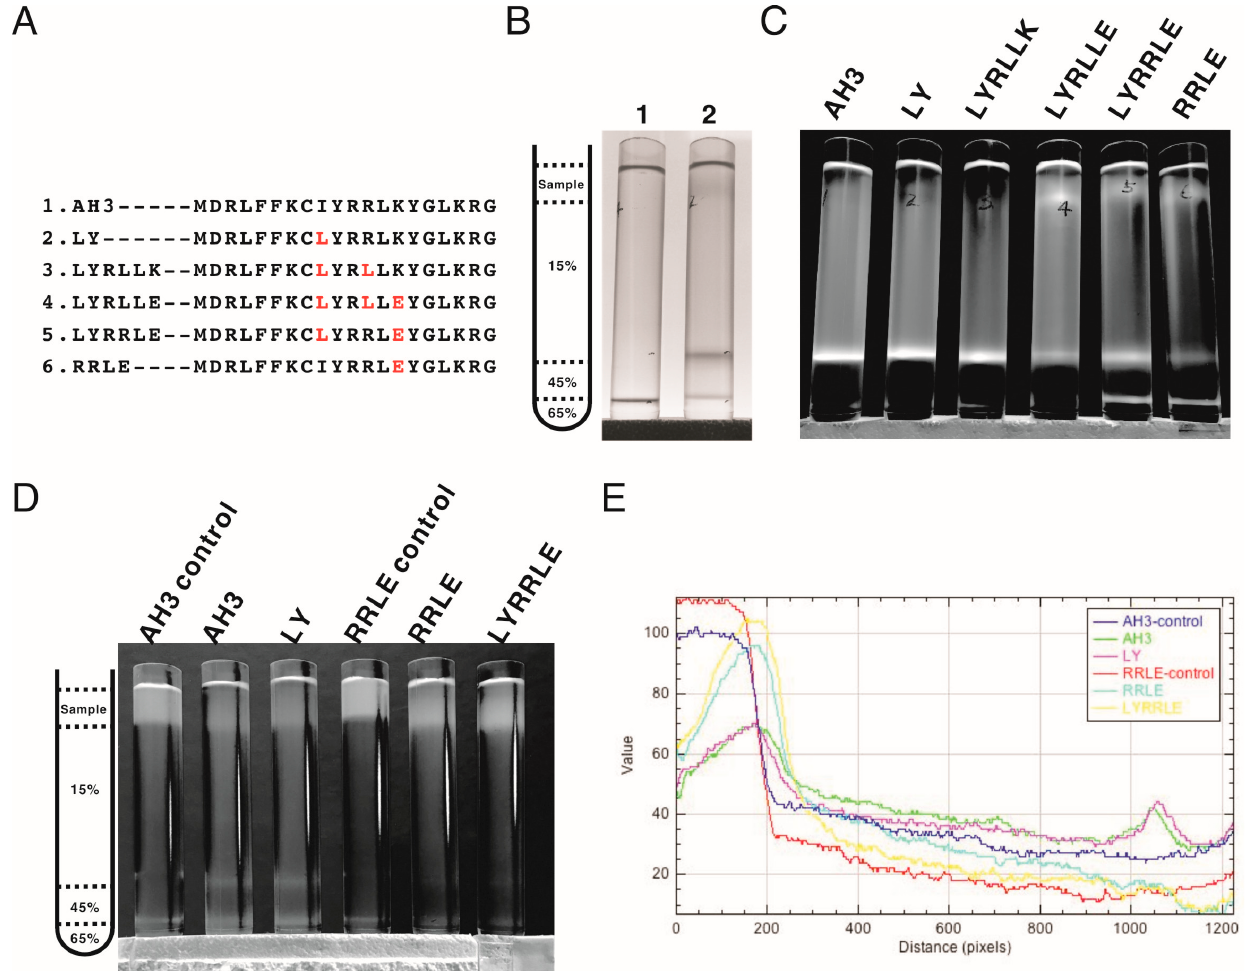
Figure 4. The co-sedimentation analysis of AH3–sfGFP–2xhM2e variants with bacterial membranes by analytic ultracentrifugation. ( A ) List of AH3 peptide variants introduced on the AH3–sfGFP–2xhM2e fusion protein for co-sedimentation analysis. ( B ) The right panel shows the graphic presen-